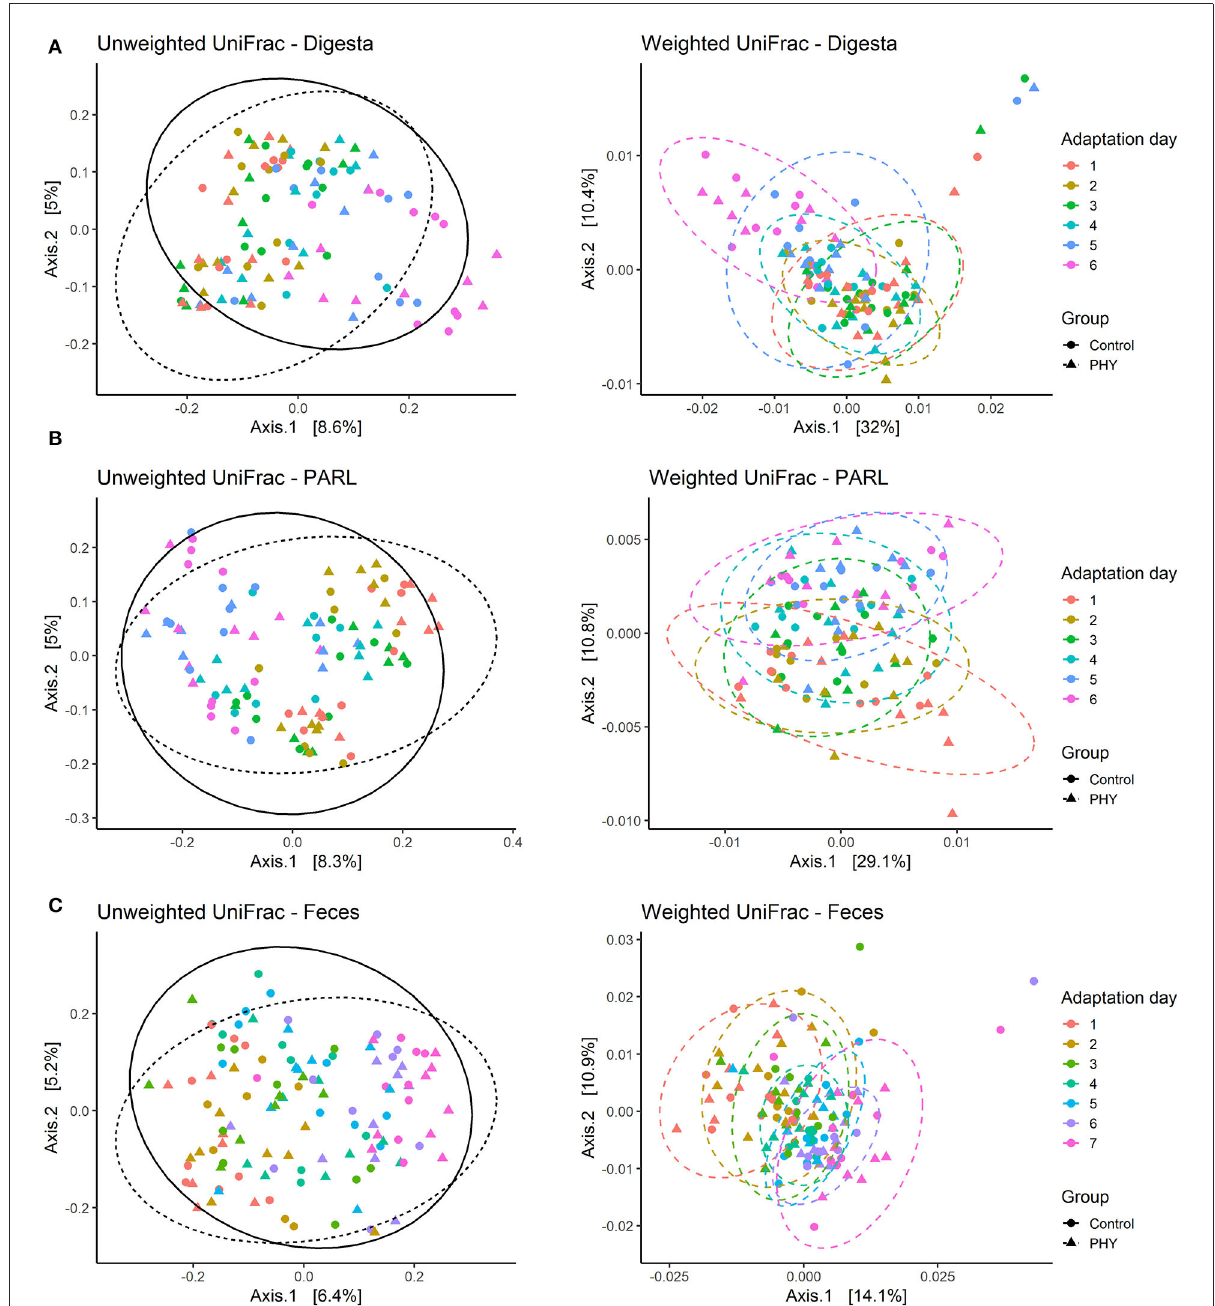
FIGURE2 Beta-diversity for the three matrices analyzed. Graphs show weighted and unweighted UniFrac analysis over the experimental days for control and treatment (PHY) groups. (A) In solid digesta samples (Digesta), adaptation day impacted both weighted and unweighted UniFrac ( P < 0.01), while the PHY treatment showed an effect only for the unweighted UniFrac ( P < 0.01). (B) Beta-diversity in PARL was affected by the adaptation day ( P < 0.01), while only unweighted UniFrac was affected by the PHY treatment ( P = 0.03). (C) In feces, adaptation day had an effect on both beta diversity matrices ( P < 0.01), while the treatment only showed a trend for unweighted UniFrac ( P = 0.08).